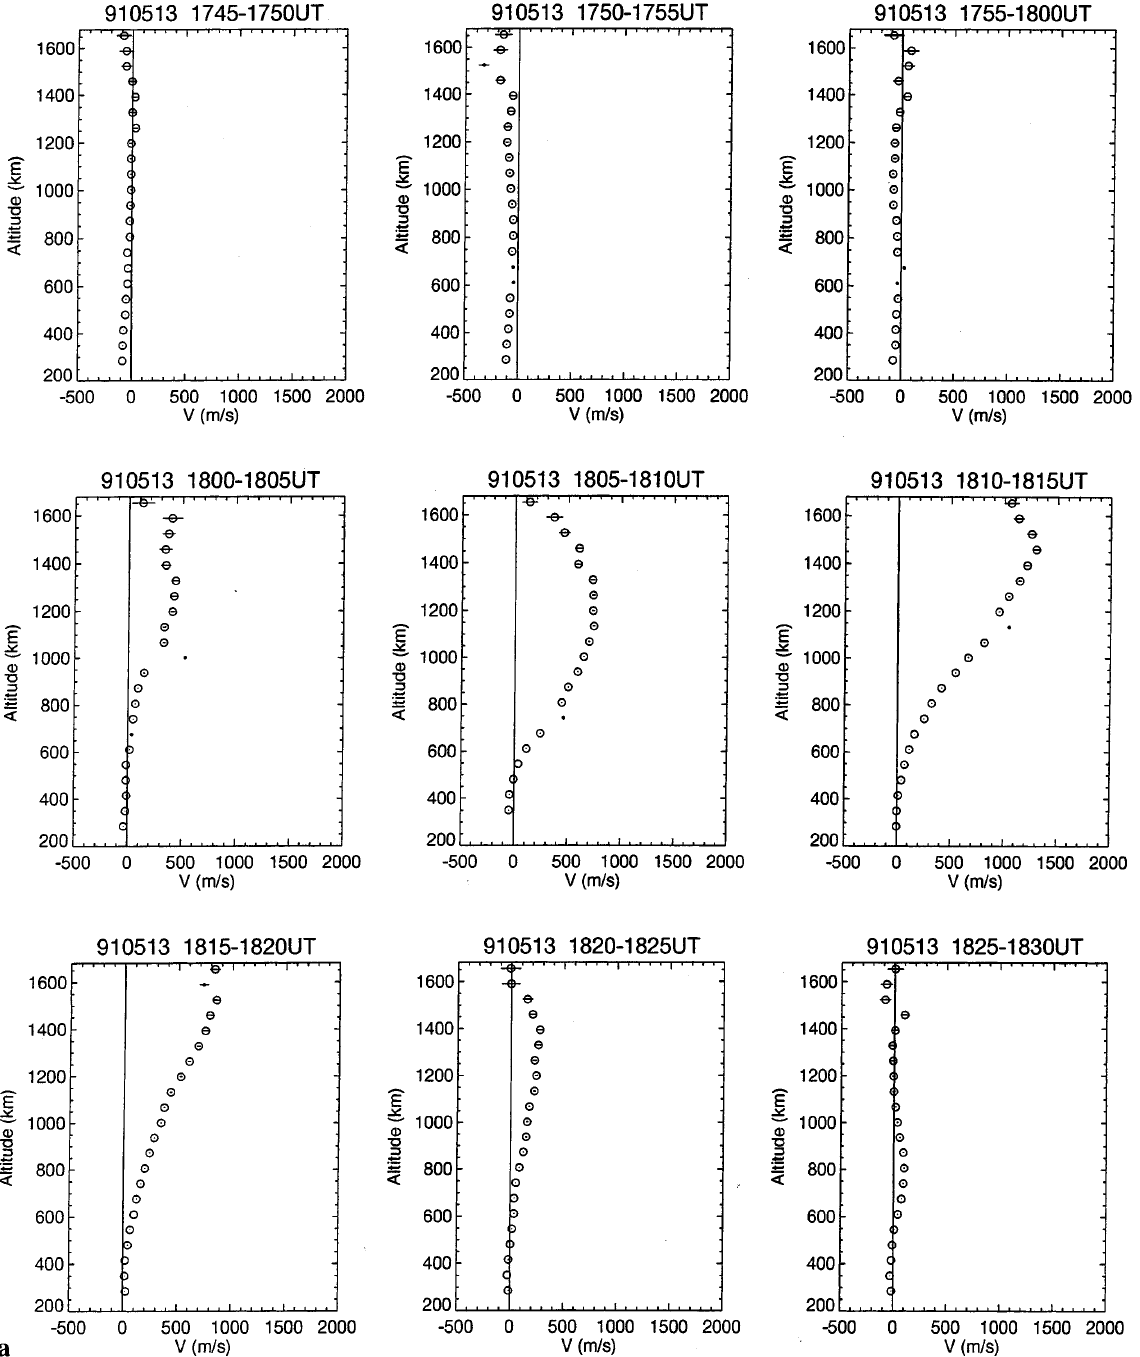
ions moving upward (downward). The circles represent good quality data and the dots represent not very good quality data judging from the degree to which well-observed EISCAT spectrum is fitted to a